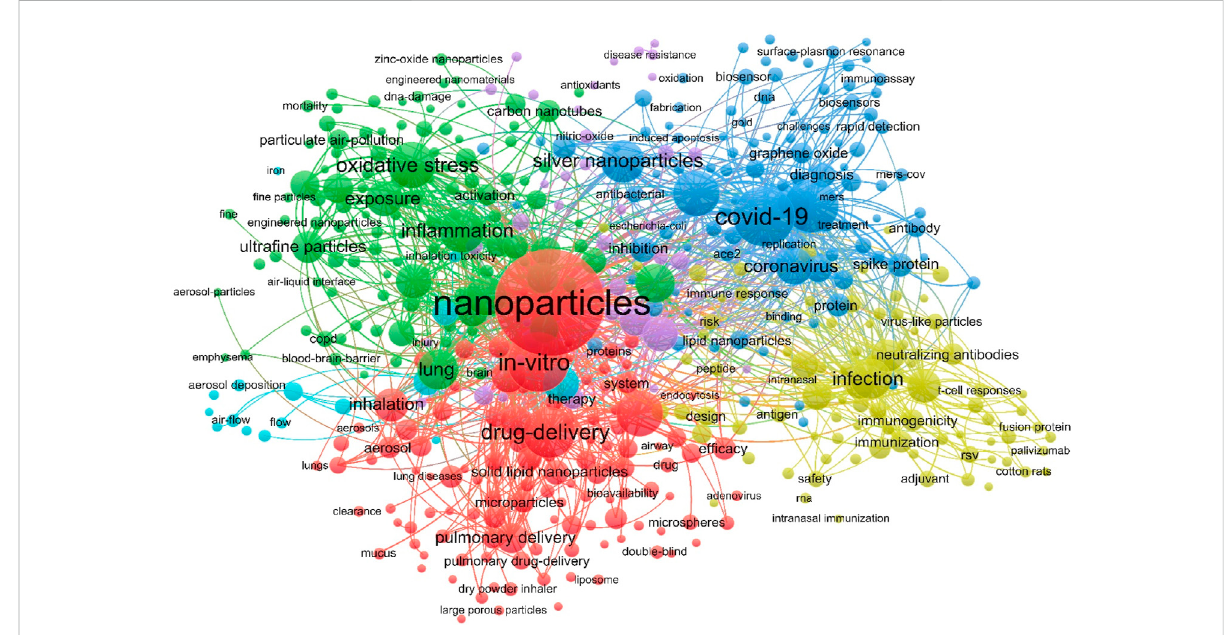
FIGURE 2 The network map of the keyword clusters in the area of nanoparticles used in respiratory